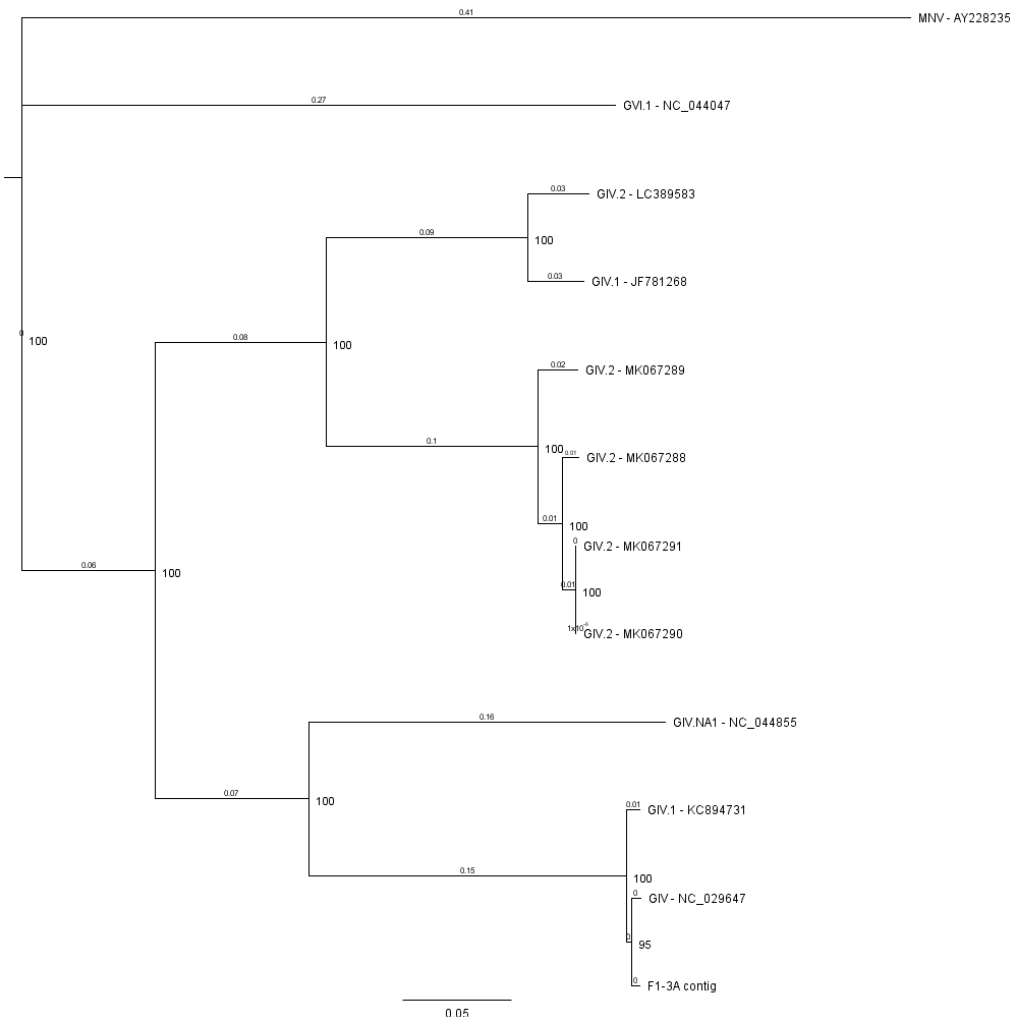
Figure 2. Phylogenetic tree of the almost-complete NoV GIV sequence from the F1-3A pool. Full genome sequences of NoV GIV are available at GenBank and were aligned using MUSCLE (Geneious 11.1). The murine norovirus sequence (accession number: AY228235) was used to root the tree. The tree was constructed with the Tamura-Nei genetic distance model using the neighbor-joining method with 1000 bootstrap replicates. The nodes labels indicate the consensus support whereas the labels on the branch indicate the number of substitutions per site.